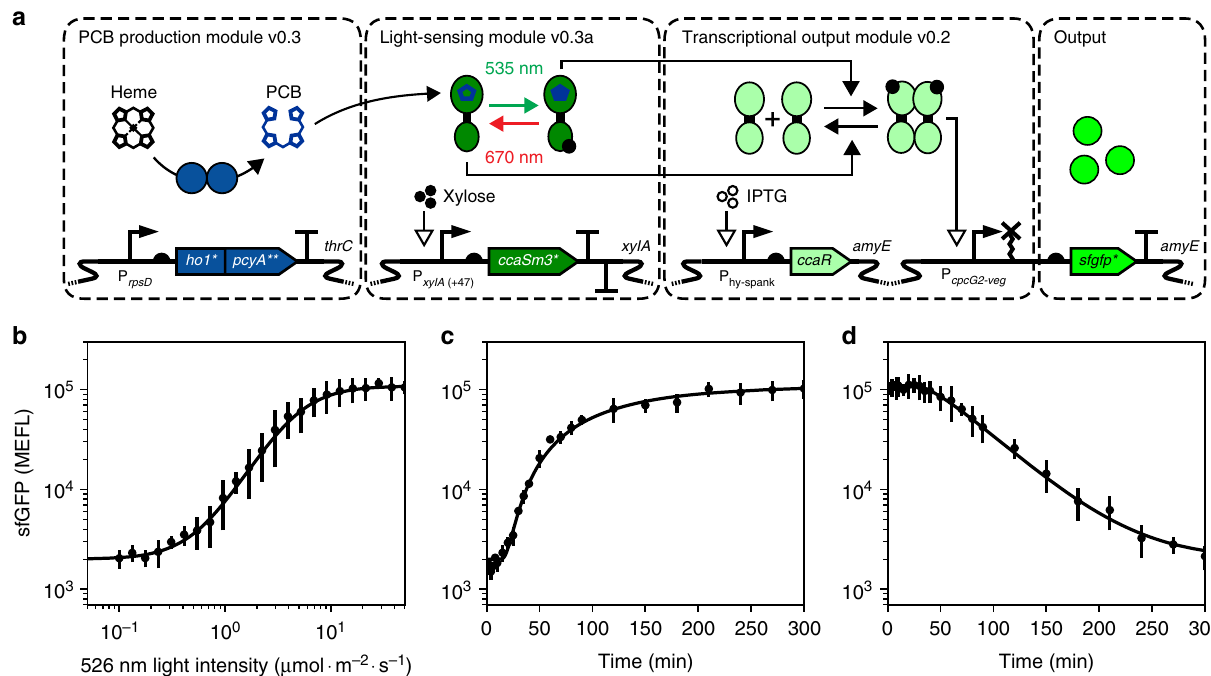
Fig. 6 Characterization of B. subtilis CcaSR v1.0 input/output properties. a Schematic of the fi nal B. subtilis CcaSR v1.0 design. b Steady-state transfer function. c Step ON response. d Step OFF response. Dots and error bars show the mean and standard deviation, respectively, of three experiments run on separate days. Black lines represent model fi ts (see “ Methods ” section). Source data is available in the Source Data fi